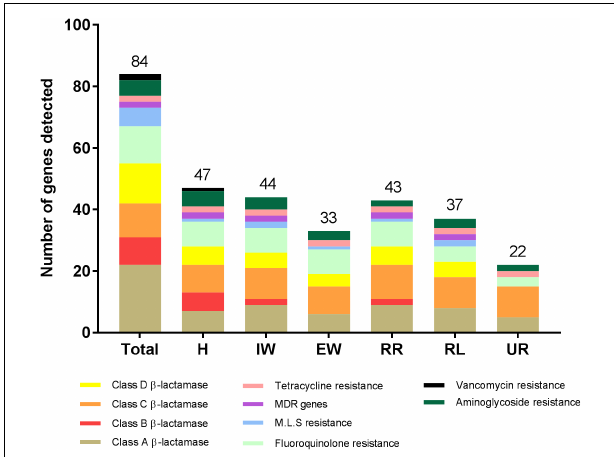
FIGURE 3 | The number of antibiotic resistance genes (ARGs) detected from wastewater and environmental waters in Örebro Sweden. Wastewater samples were taken from hospital effluent (H), incoming wastewater to WWTP (IW), and effluent wastewater (EW). Environmental water samples were taken from Svartån River upstream of Örebro city (UR), Svartån River downstream of WWTP (RR) and Hjälmaren Lake (HF), which is one nautical mile downstream of RR. The number at the top of each bar indicates the total number of detected ARGs in a particular location. MDR indicates multi-drug resistance efflux pump genes. M.L.S indicates genes conferring resistance to either of the macrolide, lincosamide, and streptogramin B